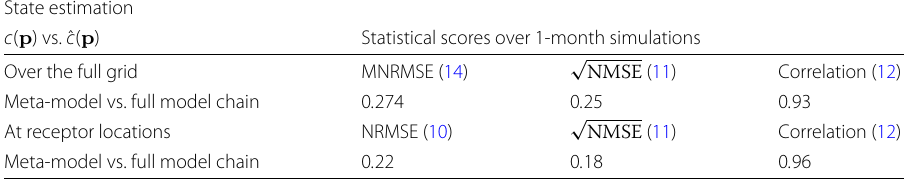
Table 3 Statistical scores of the meta-model approximation results compared to the scores of the model chain using the full air quality model State estimation c ( p ) vs. ˆ c ( p ) Statistical scores over 1-month simulations Over the full grid Meta-model vs. full model chain At receptor locations Meta-model vs. full model